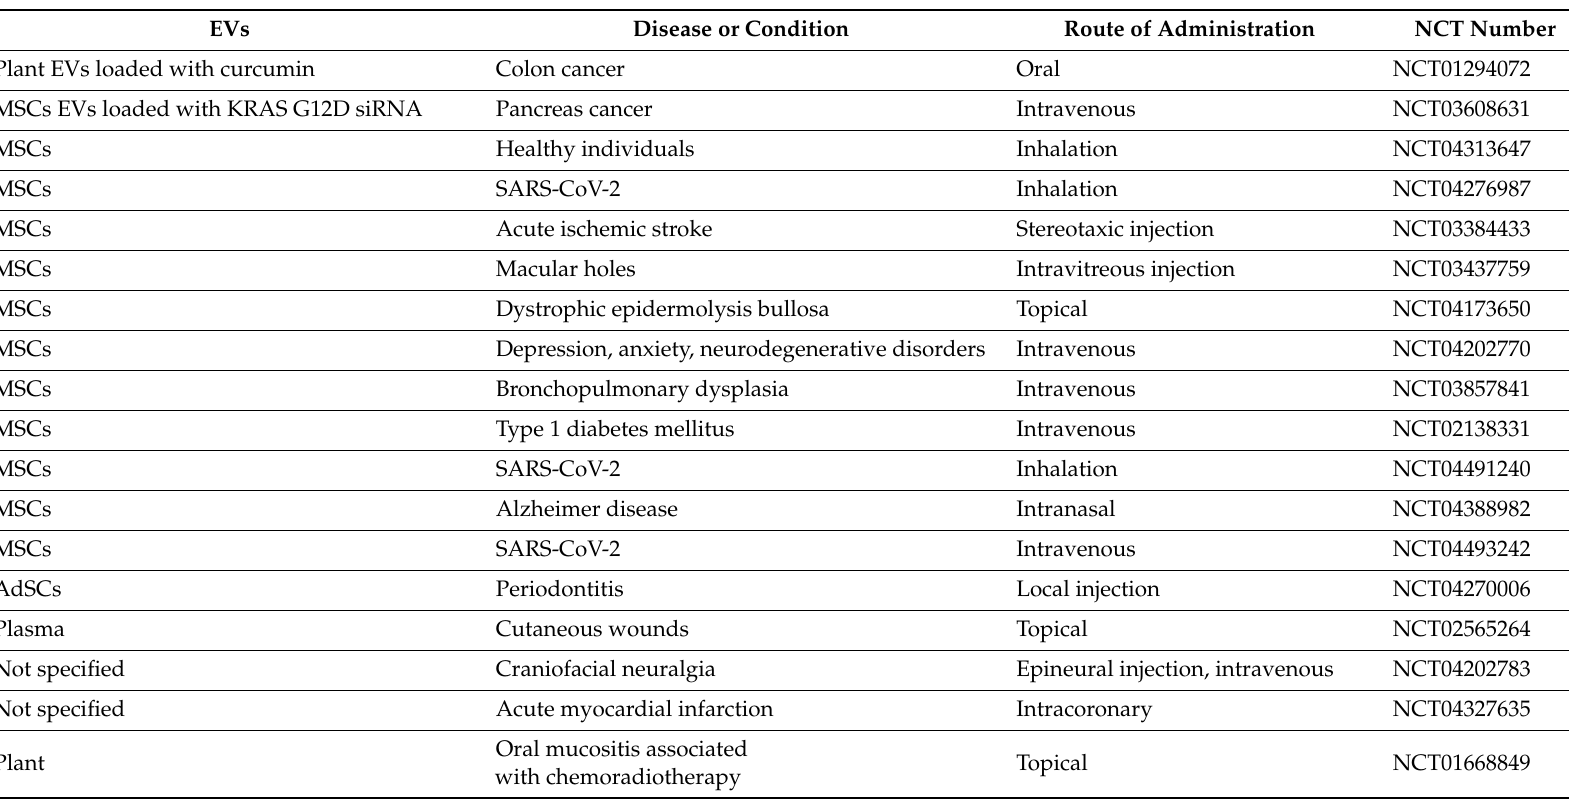
Table 3. Clinical trials registered at clinicaltrials.gov using EVs for therapeutic purposes. Studies using EVs as a drug delivery system are highlighted in bold. Abbreviations: AdSCs: adipose tissue stem cells; MSCs: mesenchymal stem cells; SARS-CoV-2: several acute respiratory syndrome coronavirus